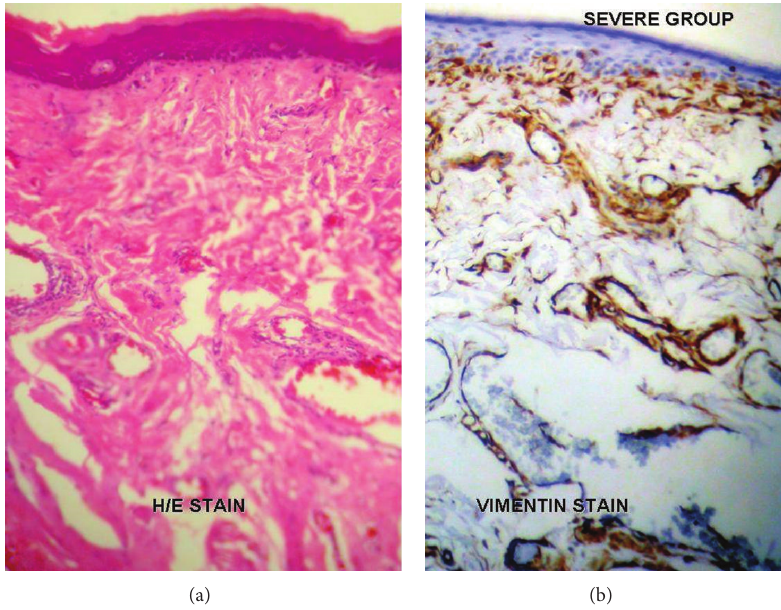
Figure 3: (a) Severe cases of oral submucous fibrosis under H/E staining. (b) Severe cases of oral submucous fibrosis under vimentin immunohistochemical staining. Note the intense vimentin staining in the subepithelial zone and the deeper zone of the connective tissue stroma. Table 1: Pattern of vimentin scores at superficial localization in mild OSF cases, severe OSF cases, and control group. Group